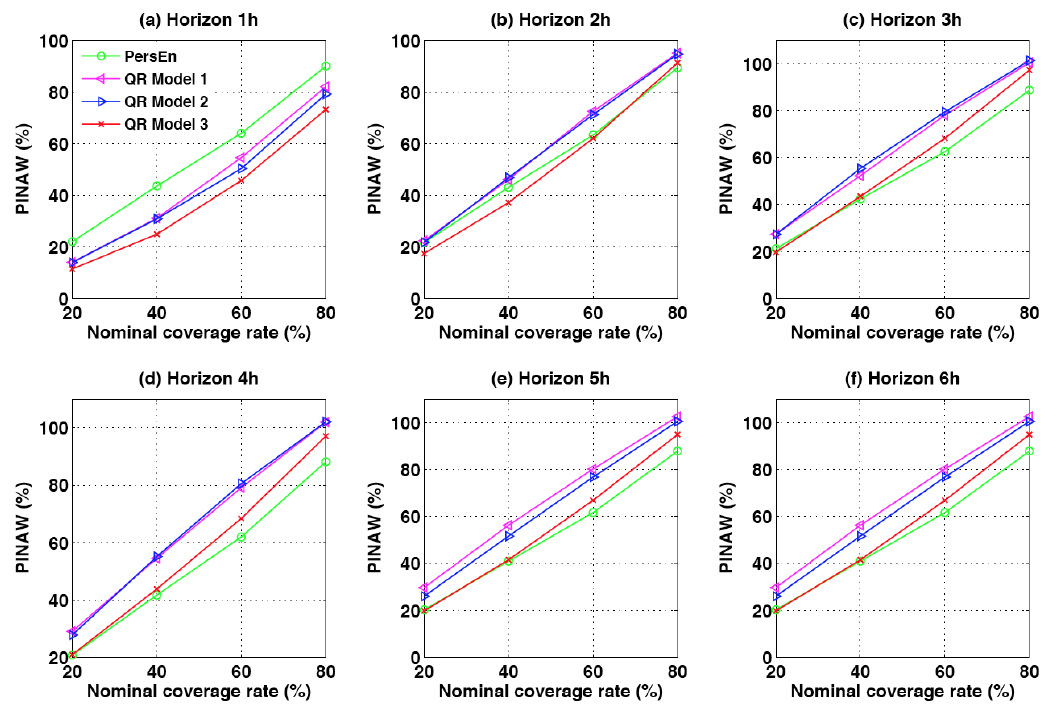
Figure 6. PINAW diagrams for different values of forecast horizon and nominal coverage rate (site of Le Tampon). ( a ) Horizon 1 h; ( b ) Horizon 2 h; ( c ) Horizon 3 h; ( d ) Horizon 4 h; ( e ) Horizon 5 h; ( f ) Horizon 6 h.